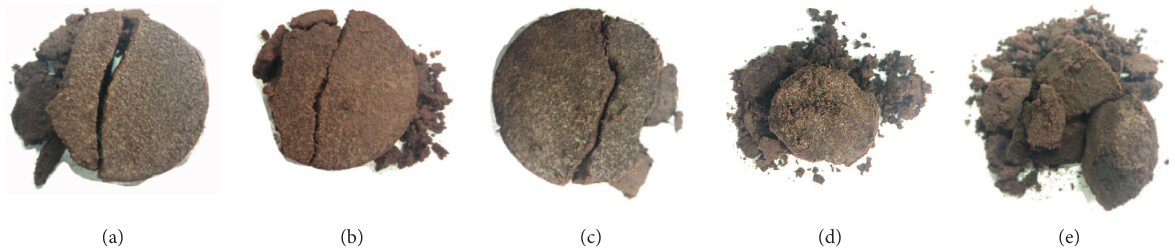
Figure 12: Typical failure modes of saturated frozen sandstone at − 10 ° C: (a) 102s − 1 ; (b) 125 s − 1 ; (c) 144s − 1 ; (d) 185 s − 1 ; (e) 210s − 1 .